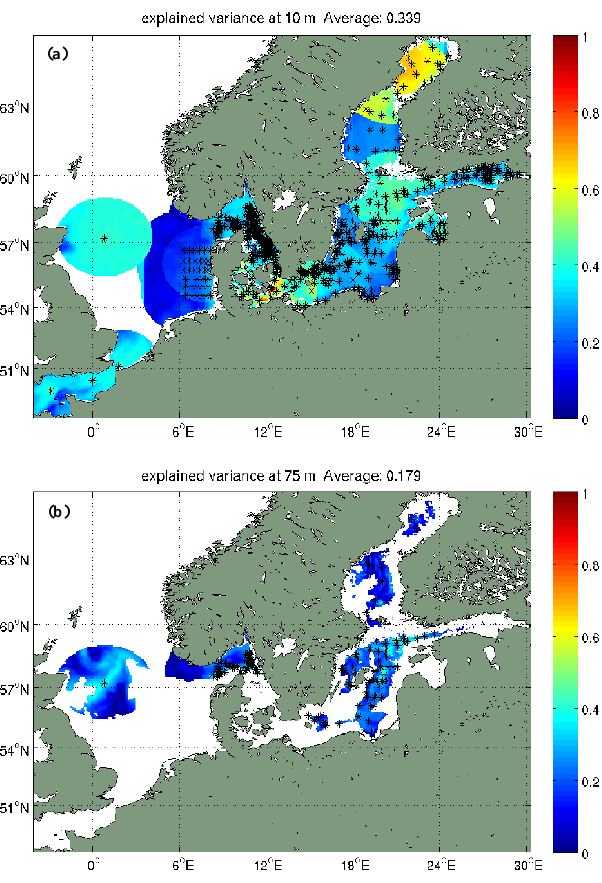
Fig. 12. Explained variance at the depth of (a) 10m and (b) 75m for